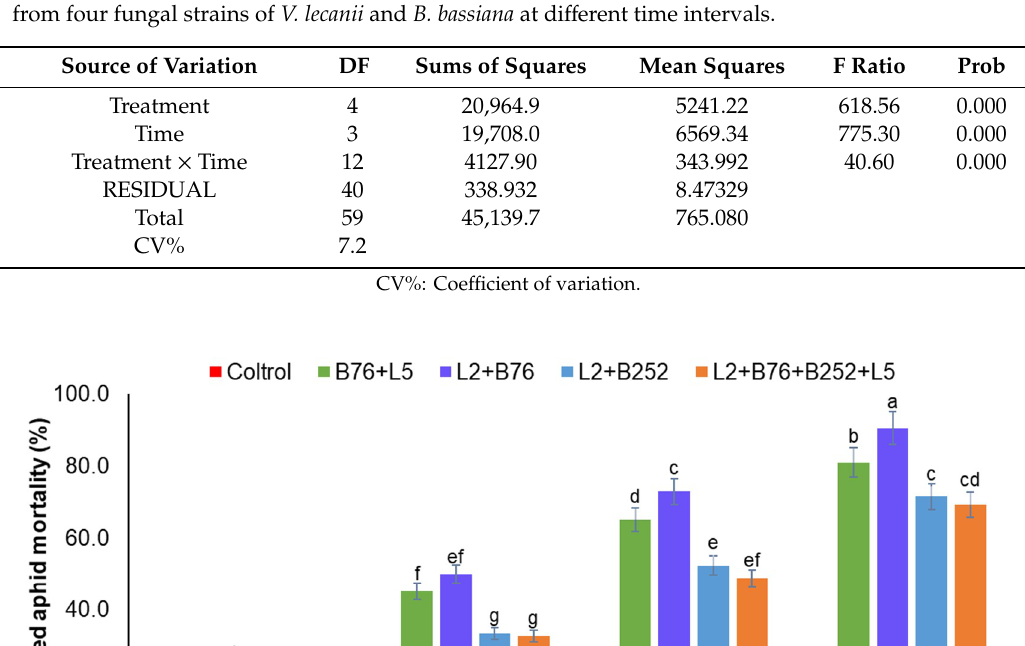
Table 3. Analysis of variance (ANOVA) for the comparison of the mortality of M. japonica by filtrate and the conidia from di ff erent fungal strains ( V. lecanii and B. bassiana ). CV%: Coefficient of variation. Source of Variation DF Sums of Squares Mean Squares F Ratio Prob